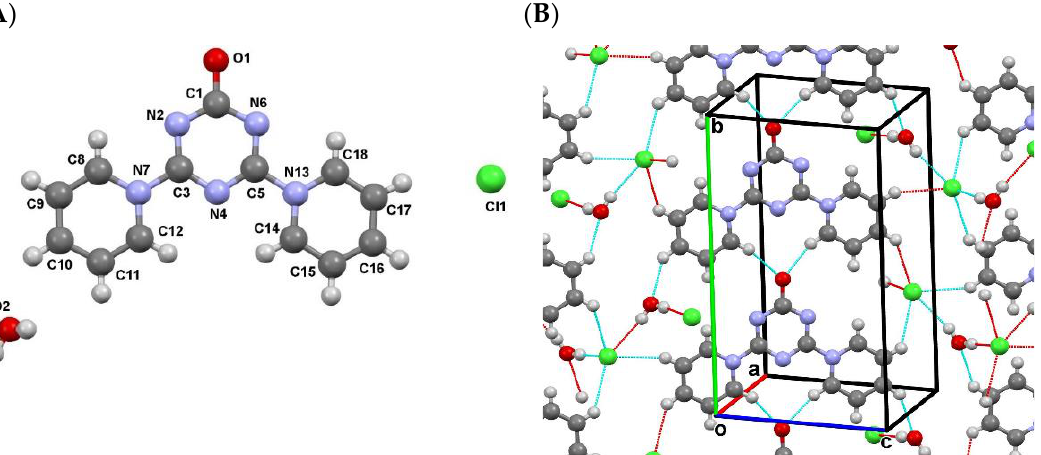
z ) 3.262(9) Å, Cl1. . . N7(1 + x , y , 1 + z ) 3.394(8) Å.